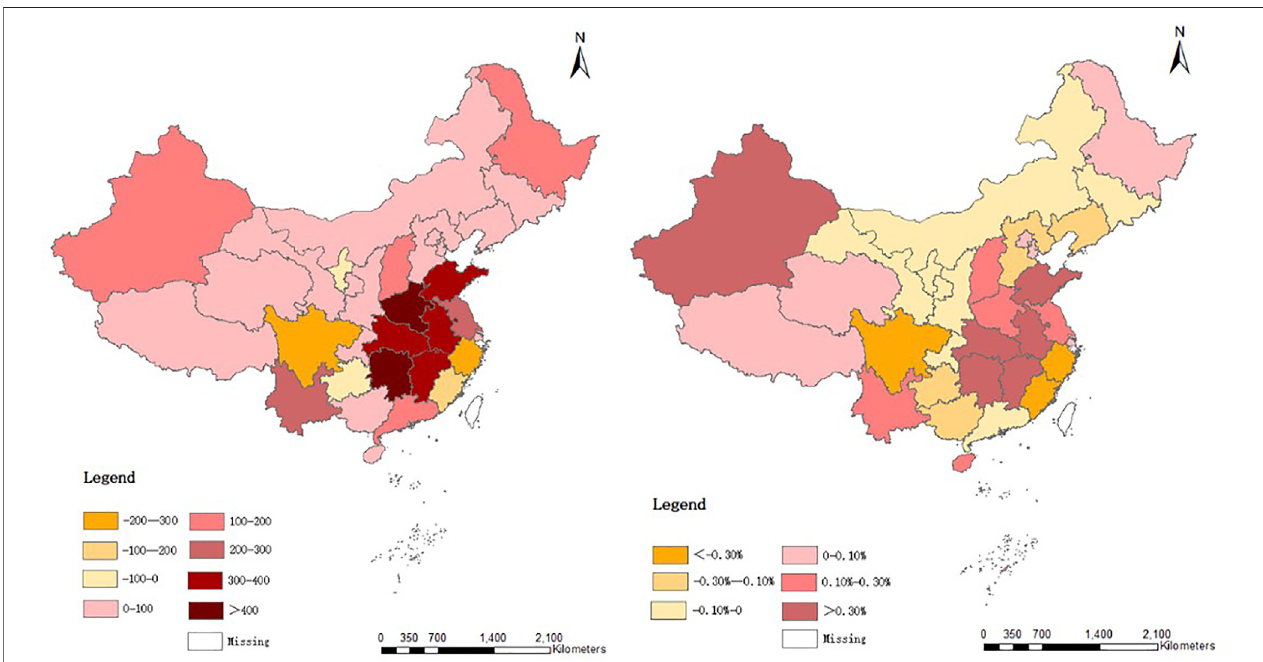
FIGURE2| Changing trendofthehoginventoryand environmental regulationstringency from 2006to2015.Note: First panel showsthechangingquantityofhog inventory (10,000 heads) in each provinceand second panel shows thechanging share ofhoginventory foreach provincein thewhole nationfrom 2006 to2015,which was our study